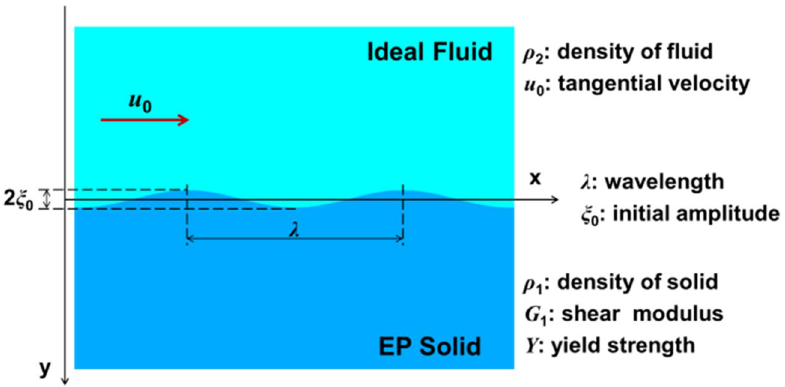
Figure 1. The configuration of ideal fluid flowing over a perturbed surface of perfectly EP metal. The solid with density ρ 1 is quiescent in the 2D Cartesian coordinate system and the fluid with density ρ 2 has a constant tangential velocity u 0 in x direction. The initial perturbation has a cosinusoidal form ξ 0 cos kx with periodic wavelength λ and amplitude ξ 0 . Both thicknesses h 1 and h 2 of materials are large enough to make sure approaching infinite medium, i.e. kh 1 >> 1 and kh 2 >>